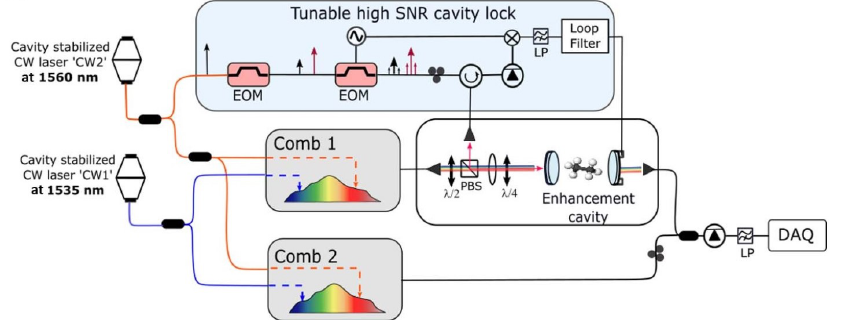
Figure 2. Schematic of dual cavity-enhanced (CE)-direct frequency comb spectroscopy (DFCS). Part of the light from one of the reference lasers is frequency-shifted using an electro-optic modulator (EOM), while a second EOM generates sidebands for Pound-Drever-Hall (PDH) locking of the spectroscopic enhancement cavity to the frequency-shifted reference laser. By changing the modulation frequency of the first EOM, one can align the cavity resonances with the comb modes in any location across the spectrum. Reprinted with permission from [80] ©The Optical